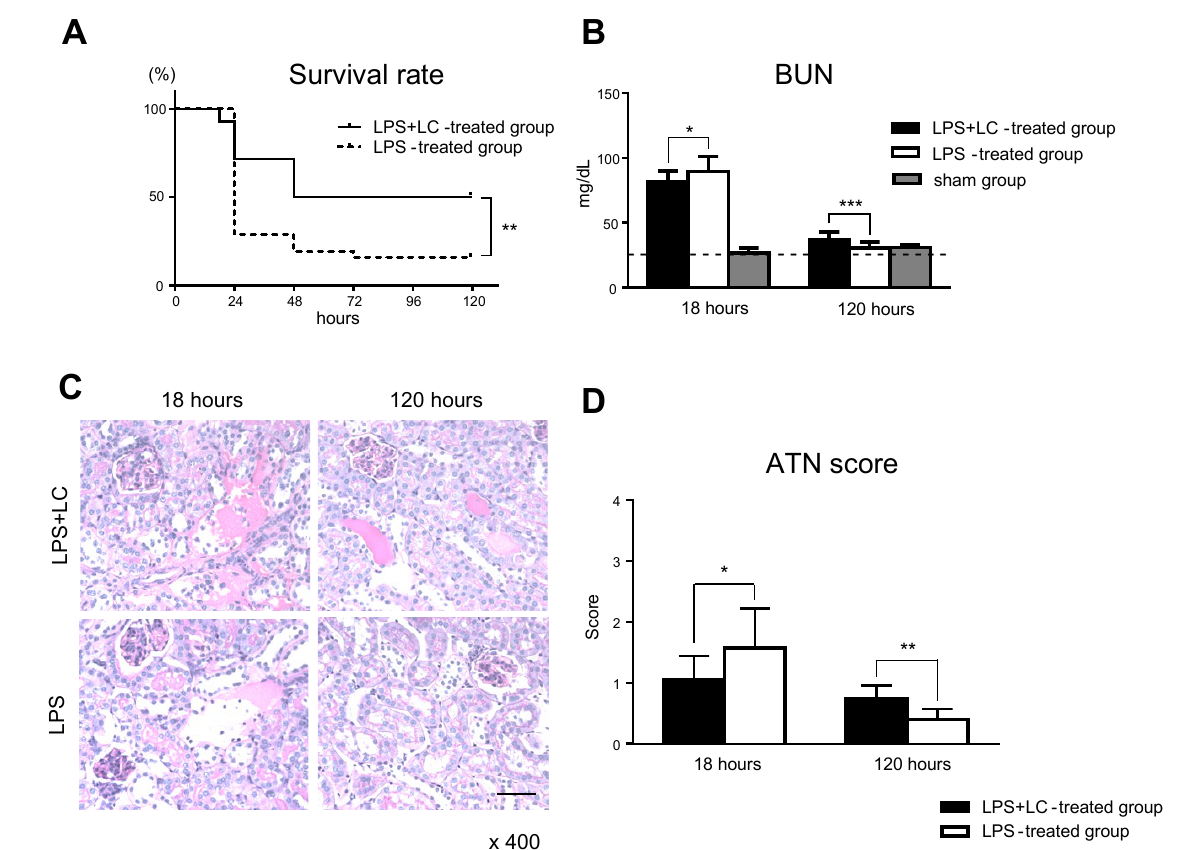
Figure 3. Effect of LC on the survival and the BUN level in the development of AKI after LPS injection. ( A ): Survival of the LPS + LC-treated mice and LPS-treated mice subjected to AKI by LPS in- jection. Mice were evaluated until 120 h after the LPS injection. ( B ): Renal function of the LPS + LC- treated mice and LPS-treated mice at 18 and 120 h after LPS injection, assessed by BUN levels. LC- treated mice that received saline instead of LPS were designated as the sham group, and BUN levels were also measured. ( C ): The grade of renal injury was evaluated by periodic acid–Schiff staining. Kidneys were stained with periodic acid–Schiff reagent to evaluate tubular necrosis in a semiquan- titative manner by determining the percentage of cortical tubules in which epithelial necrosis, loss of the brush border, cast formation, and tubular dilation were observed; ×400. ( D ): The grade of renal injury in the LPS + LC- and LPS-treated groups at 18 and 120 h after LPS injection was evalu- ated by the acute tubular necrosis (ATN) score. The data are mean ± SEM. * p < 0.05, ** p < 0.01, *** p < 0.005, LPS + LC- vs. LPS-treated group. Scale bar, 100 μm. AKI: acute kidney injury, BUN: blood urea nitrogen.